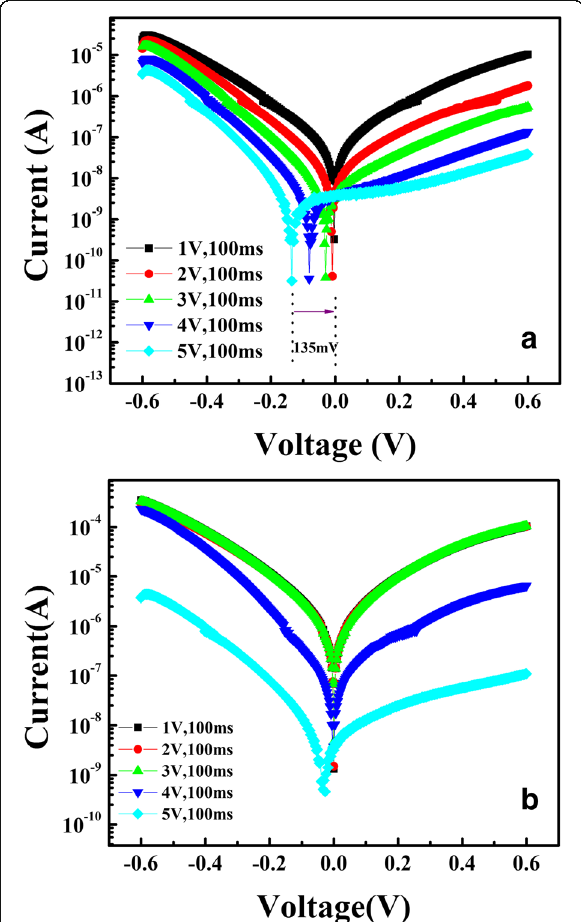
Fig. 4 The I – V curves in the low-bias regime ( − 0.6 to + 0.6 V) after switching with a series of voltage pulses from + 1 to + 5 V with 100 ms (switching from LRS to intermediate resistance states and to HRS) under a the light illumination and b dark,